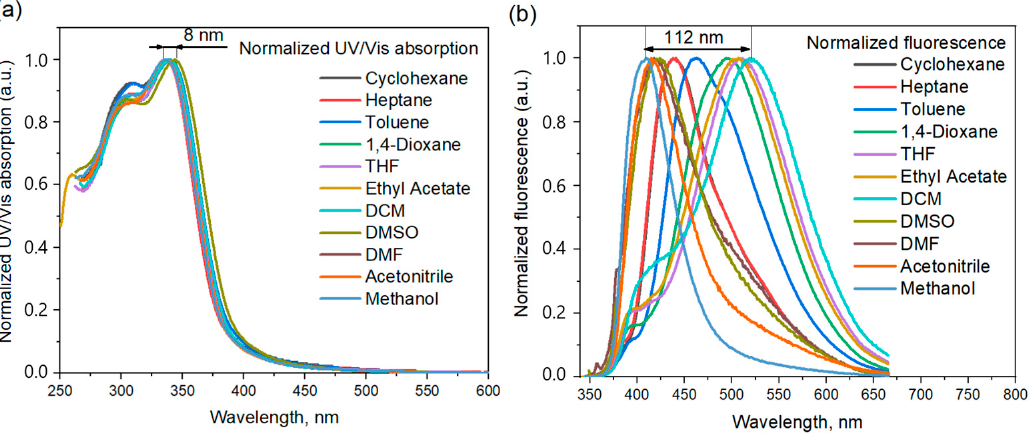
Figure 4. UV/Vis ( a ) and fluorescence ( b ) spectra of 3i in different solvents at room temperature .